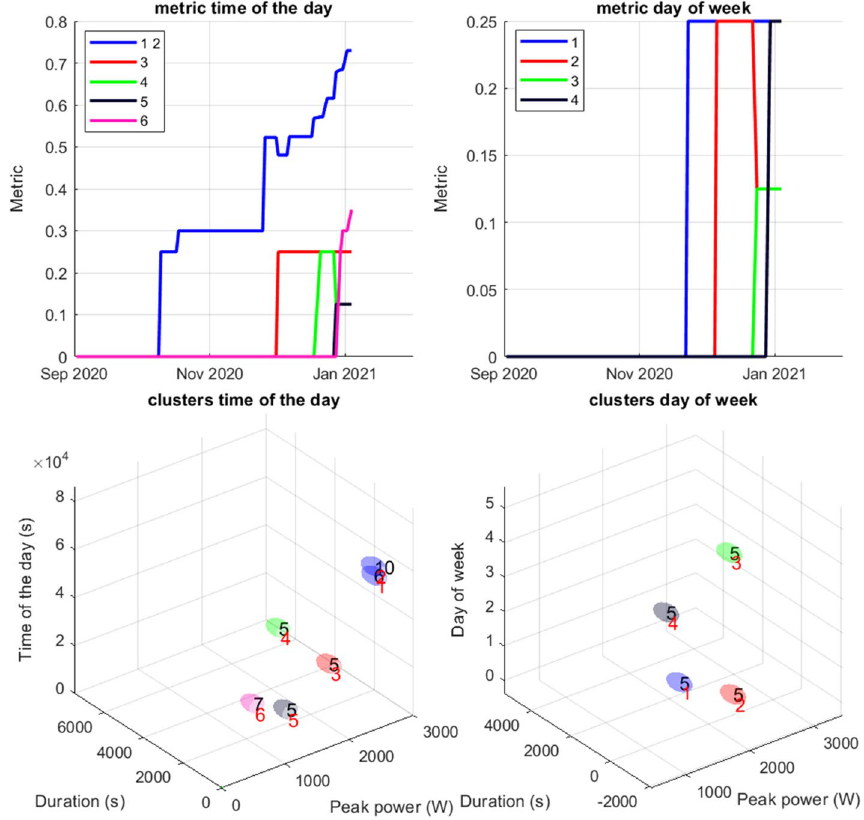
Fig. 2 Evolution of the quality metric during the online clustering process with the features combinations { peak power , duration , time of the day } on the left and { peak power , duration , day of week } on the